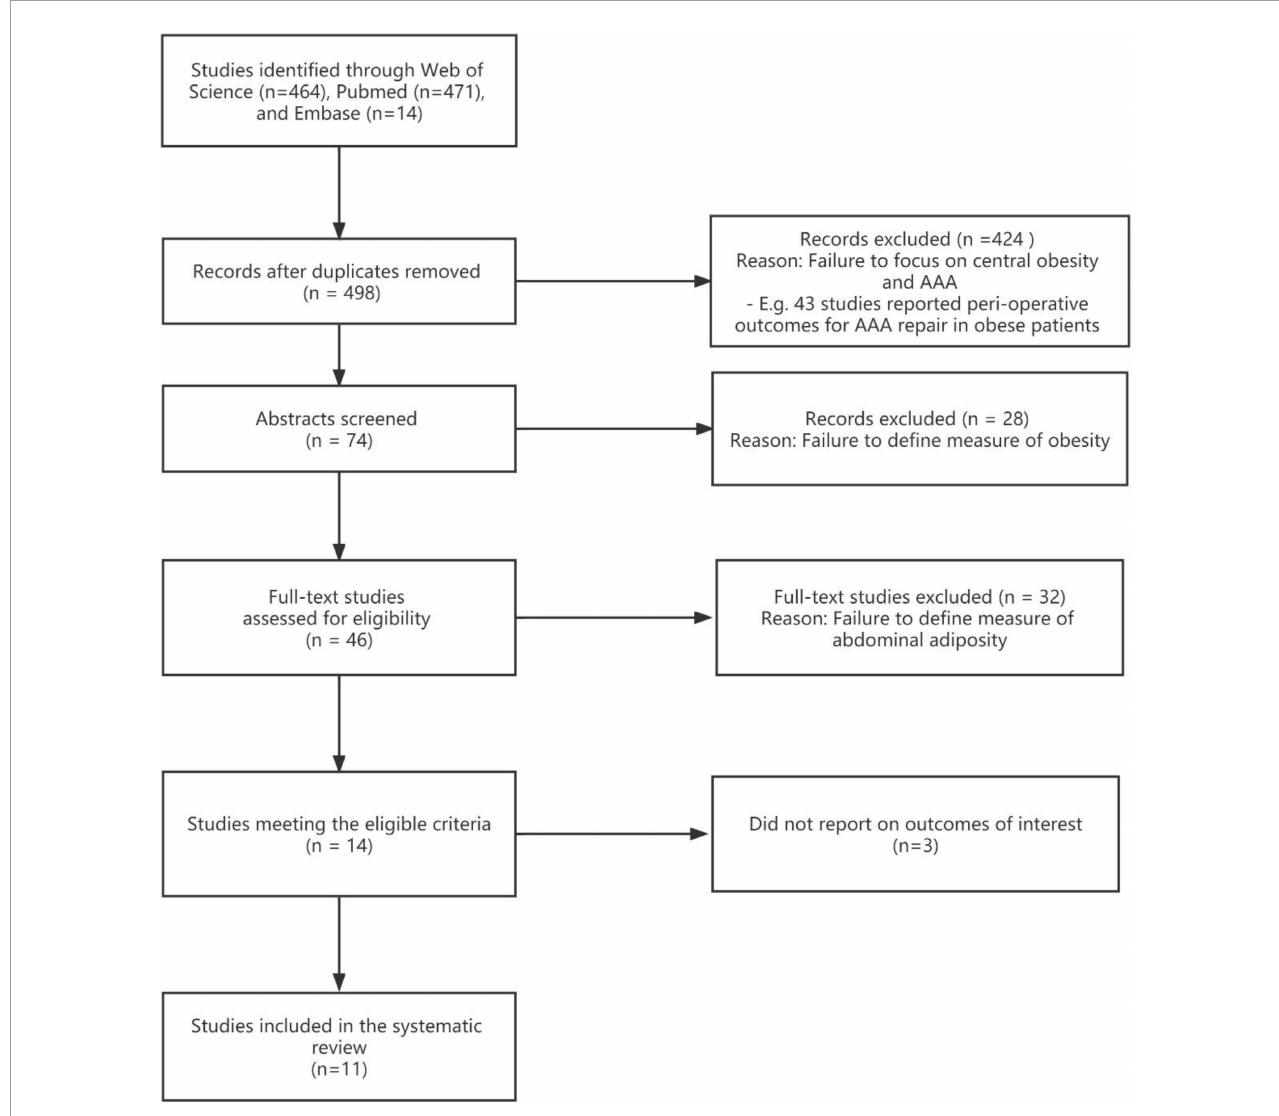
FIGURE1 Flow diagram to illustrate the trials identified for this